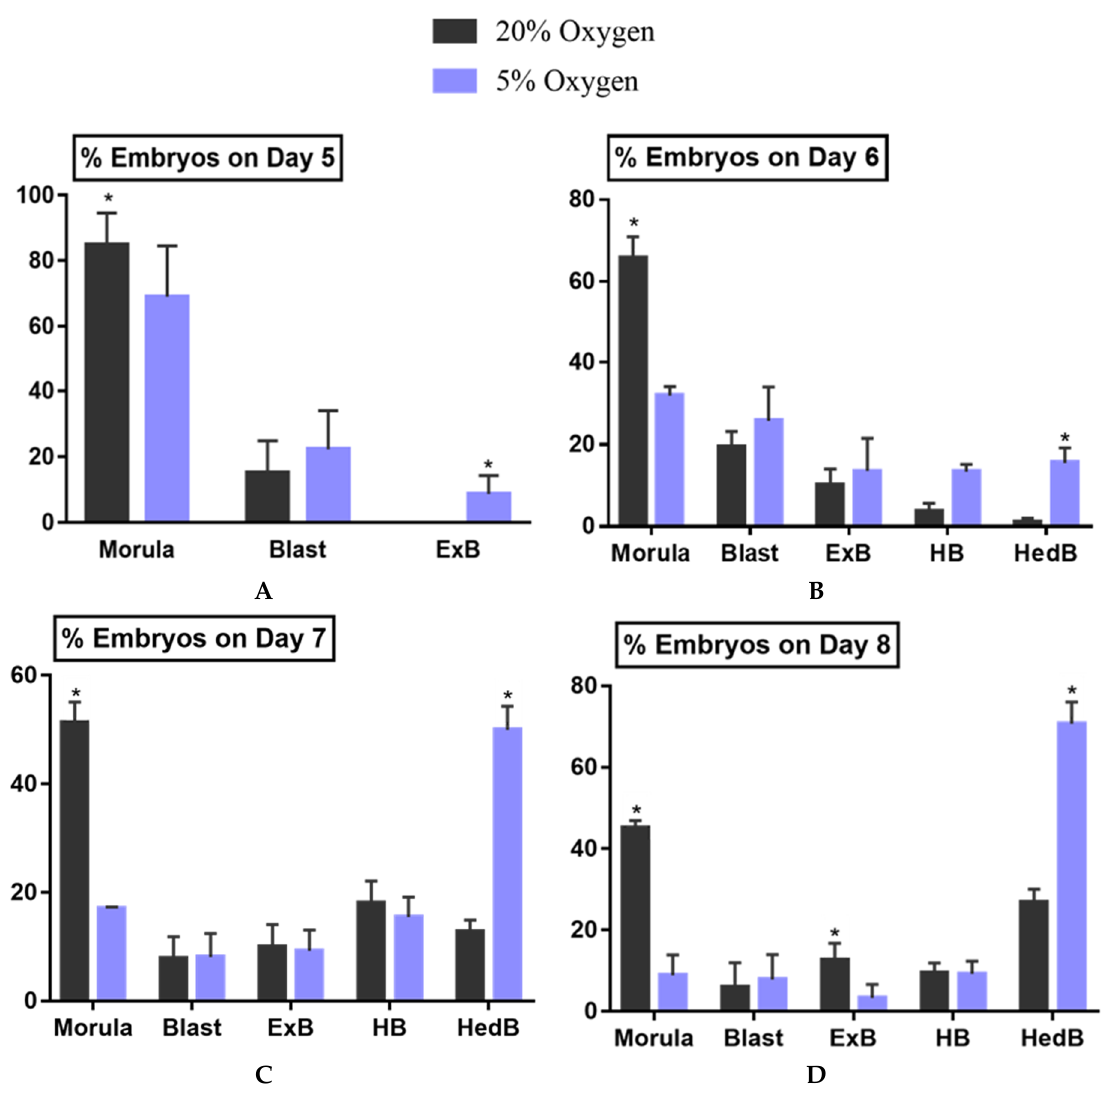
Figure 2. Effect of varying oxygen levels (20% vs. 5%) on developmental kinetics of buffalo embryos. All the experiments were replicated three times. The percentage of embryos at different developmental stages, morula, blastocyst (Blast), expanded blastocyst (ExB), hatching blastocyst (HB), hatched blastocyst (HedB), on day 5, 6, 7 and 8 was evaluated. There was a significantly higher rate of embryos at advanced developmental stages in 5% oxygen as compared to 20% oxygen. Fifty-nine and 53 embryos from 20% and 5% oxygen group, respectively, were evaluated on day 5 ( A ). Sixty-four embryos from each group were evaluated on day 6 ( B ). Sixty-three and 64 embryos from 20% and 5% oxygen group respectively, were evaluated on day 7 ( C ). Sixty-nine and 60 embryos from 20% and 5% oxygen group, respectively, were evaluated on day 8 ( D ). Values represent mean % ± S.E.M. Asterisk (*) indicates the statistical difference, p < 0.05.